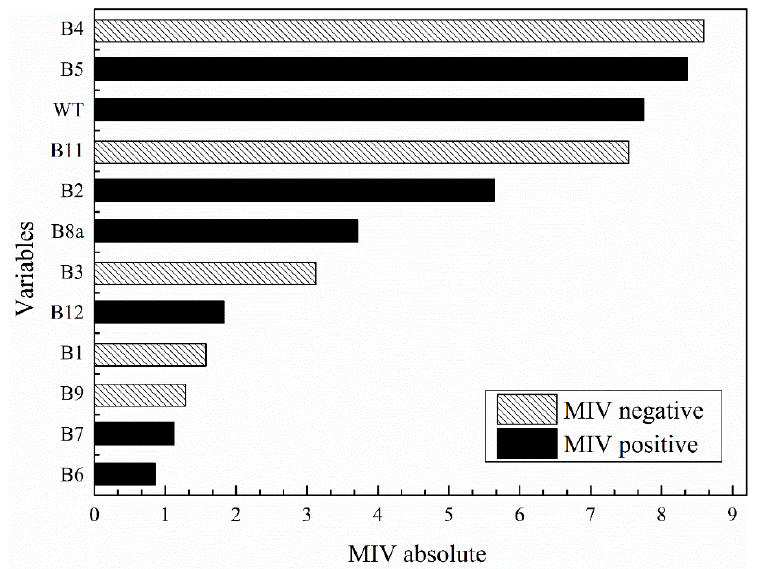
Figure 9. Variables sorted relative to the mean impact value (MIV).